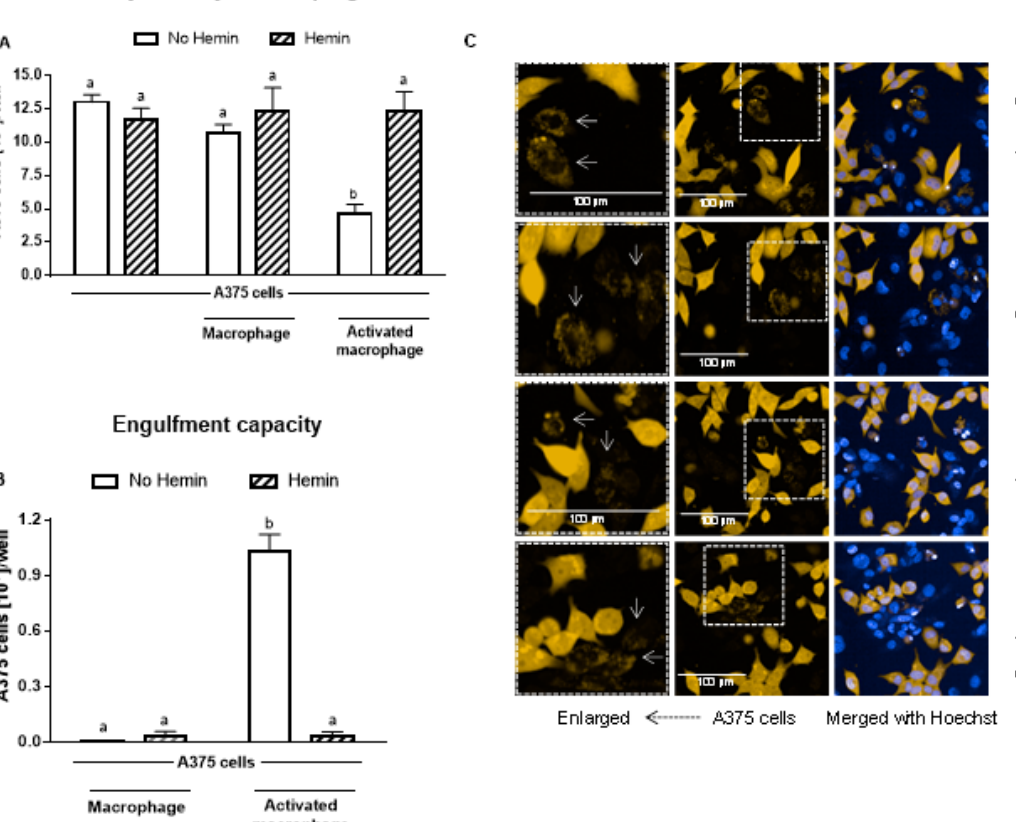
Figure 6. The increased cytotoxic effect and engulfment capacity of activated macrophages is reduced by hemin. ( A ) Cytotoxic effect of macrophages and activated macrophages against A375 cells, in the absence or presence of 10 μ M hemin for 72 h. A375 cells were counted using Harmony software (Perkin Elmer), by identifying the cells at 655 nm using a confocal imaging system. ( B ) Engulfment of A375 cells by macrophages and activated macrophages against A375 cells, in the absence or presence of 10 μ M hemin for 72 h. ( C ) Engulfed A375 cells by activated macrophages were identified as disrupted cells at 655 nm using a confocal imaging system. Nuclei of macrophages and A375 cells were identified through Hoechst (at 405 nm). Values with different superscript letters (a and b) indicate significant differences ( p < 0.05) between groups. For all bars with the same letter, the difference between the means is not statistically significant.